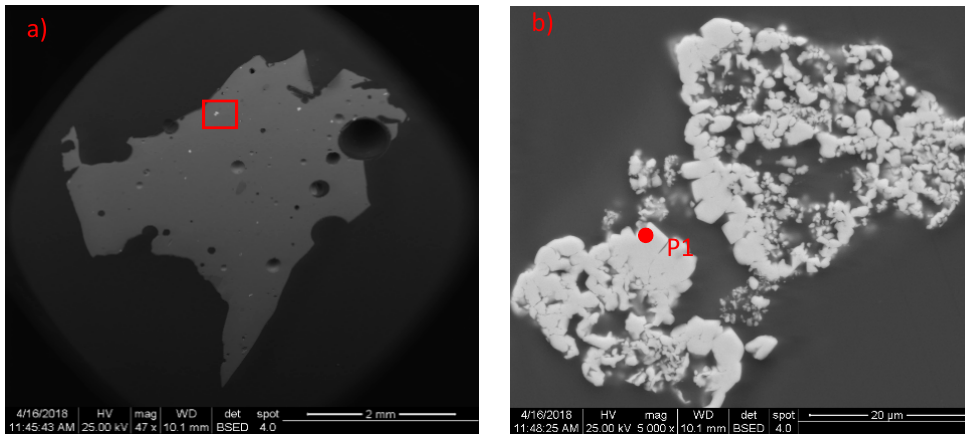
Figure 19. BSE image of the micro-texture of the vitreous matrix (SP23 white plant ash-based glass tessera from the Basilica of St. Peter in Rome, Italy [26]), showing an almost homogeneous micro-texture ( a ) with sporadic, unevenly distributed micrometric inclusions, as clusters of crystals with subhedral habit ( b ).